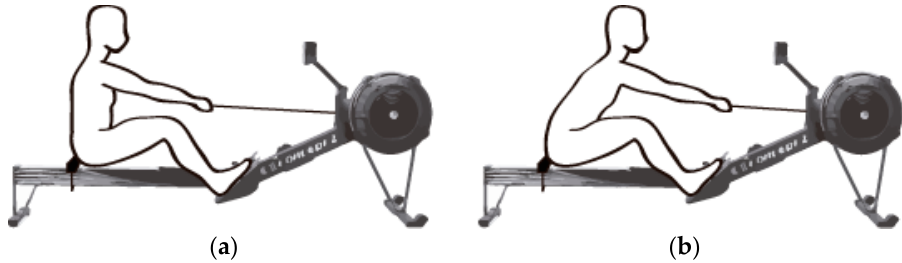
Figure 2. Differences in technique for ( a ) the first 3 strokes and ( b ) after the first 3 strokes.